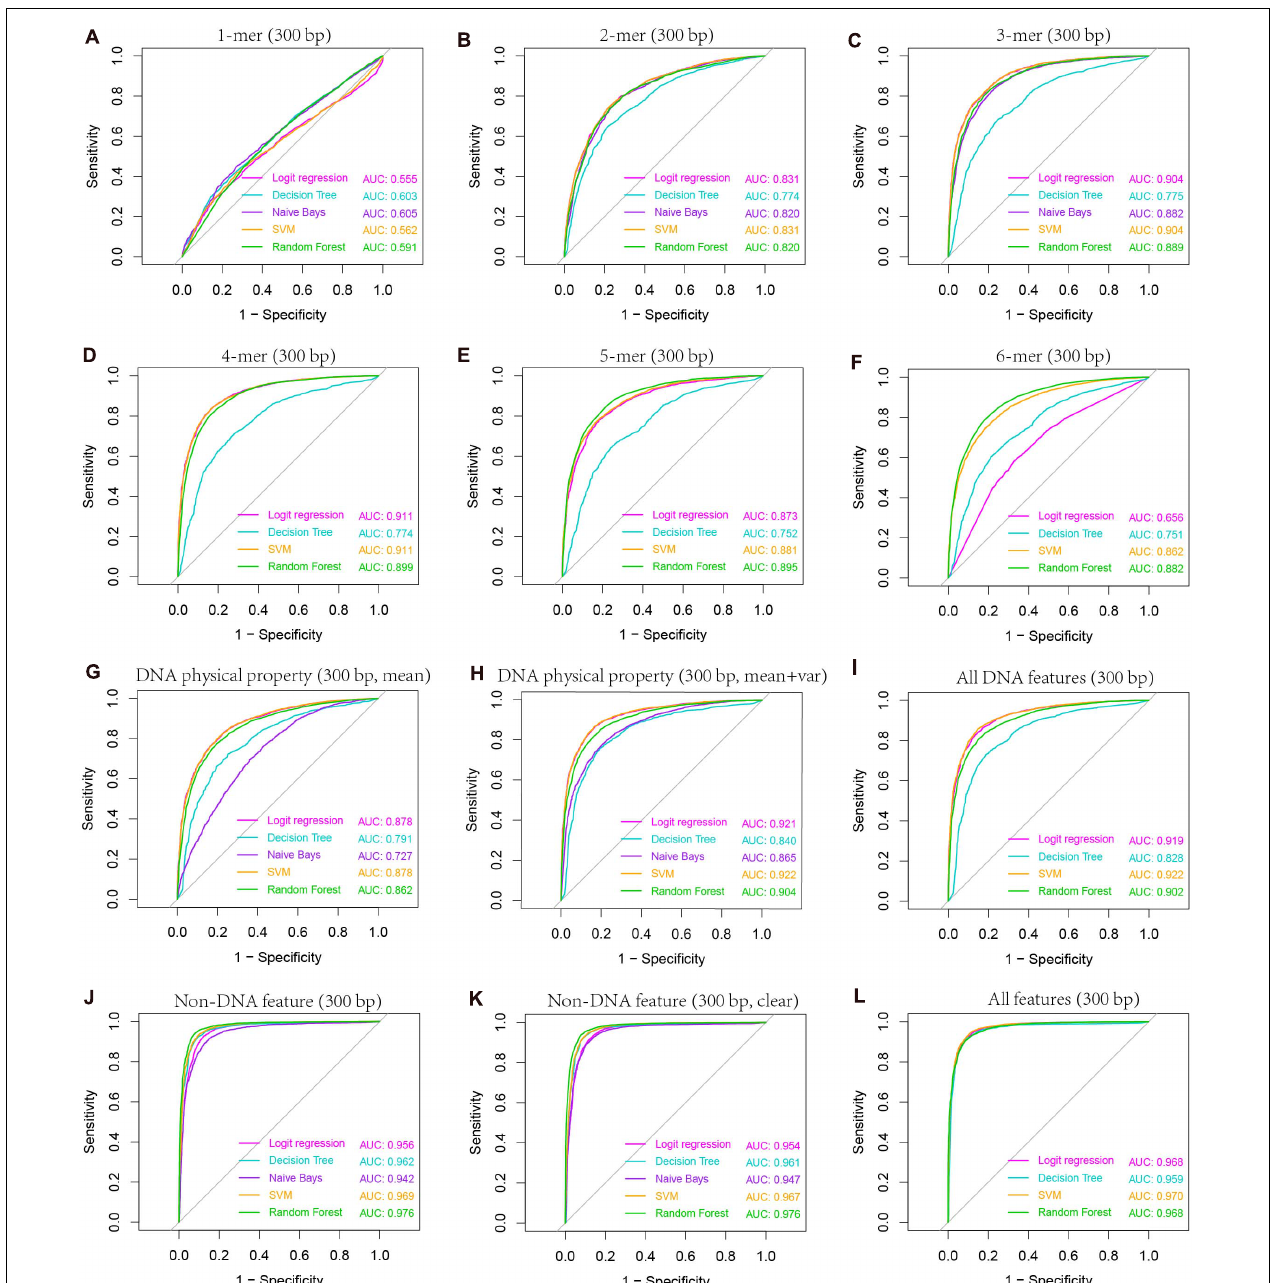
FIGURE 6 | AUC-based comparison of prediction performance between different classification models. Results are based on combined decision values inferred from five-fold cross validation. Features including k-mer composition (A–F) , DNA physical properties (G,H) , and several non-DNA features (H3K4me3, H3K56ac, MNase-seq signal, and Top2 binding signal) were obtained from 300-bp regions centered at hot/cold spots. Mean and variance were calculated for DNA physical property features by averaging across the 300-bp genomic regions for each hot/cold spot. In non-DNA features (J) , predictions were based on six features (H3K4me3_GSE11004, H3K4me3_GSE59005, H3K56ac_GSE37487, H3K56ac_GSE59005, MNase_GSE59005, and Top2_GSE136675), and those excluding two redundant features (H3K4me3_GSE11004 and H3K56ac_GSE37487) were denoted as “clear” (K) . All DNA features (I) include 4-mer composition, GC-content, GC-skew, mutual information, DNA physical property features listed in Table 1 . Note that DNA physical property features here include DNA physical properties and DNA shape parameters. All features include all DNA features and clear non-DNA features (L) .